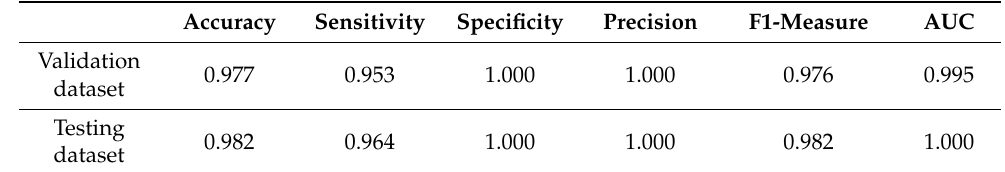
Figure 9. ( a ) Training accuracy and ( b ) training loss of ResNet model on our dataset. Figure 10. ROC curve of ( a ) validation set and ( b ) testing set. Table 1. Confusion matrix of the model.